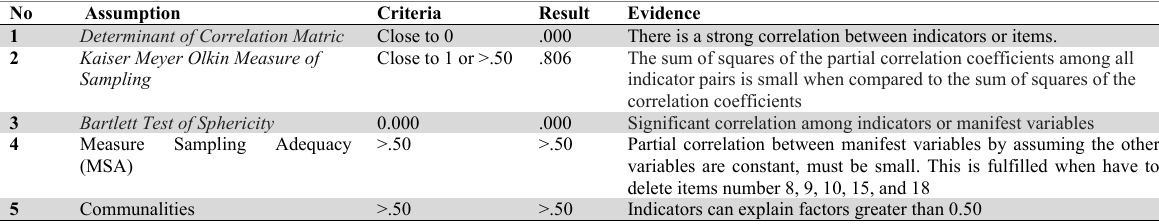
Result of Assumption